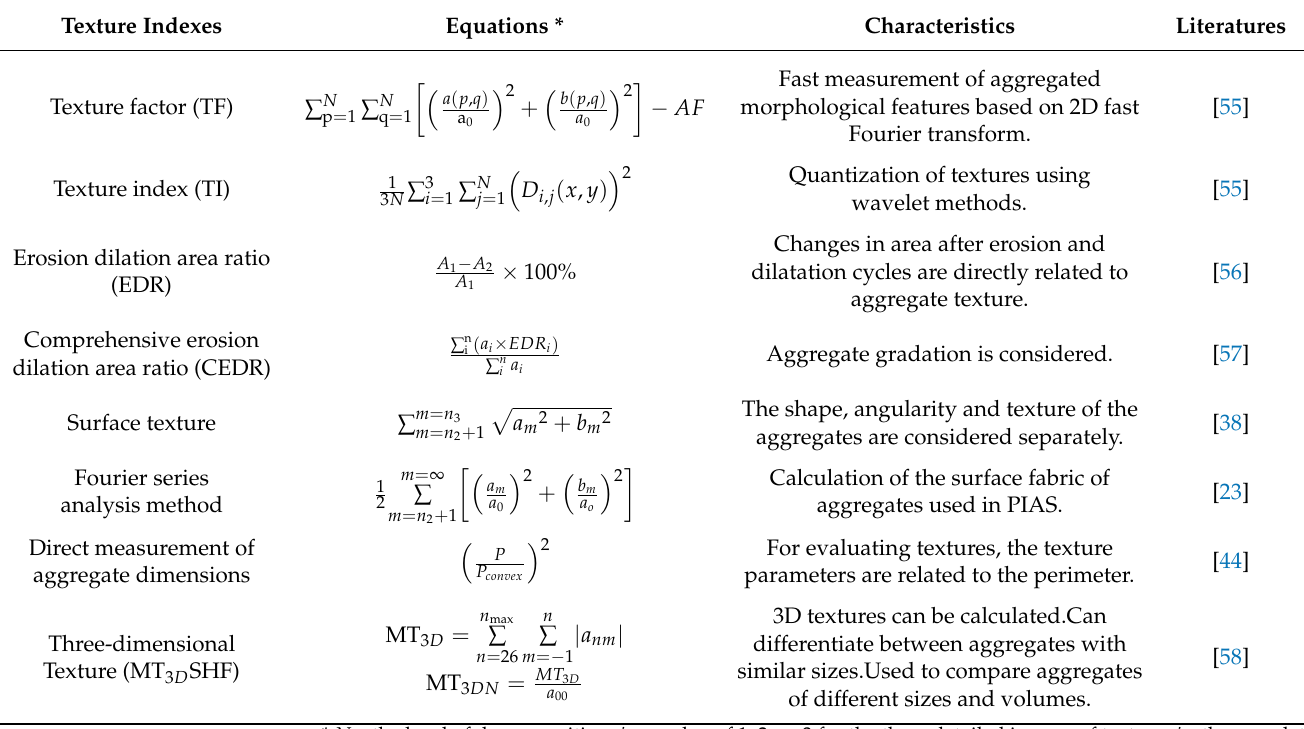
Table 3. Texture index of aggregate with calculation equations and main characteristics. Equations * Characteristics Literatures Fast measurement of aggregated morphological features based on 2D fast Fourier